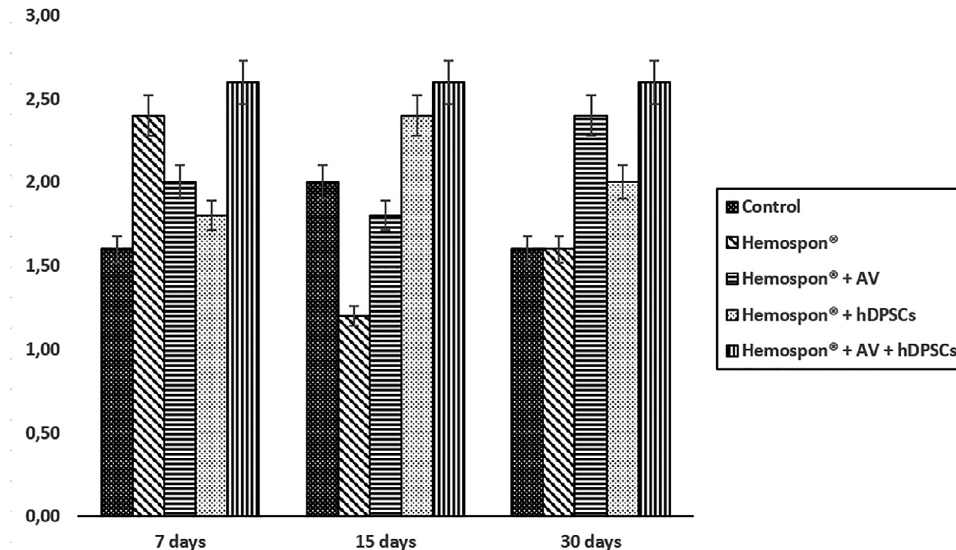
Figure 7- Average scores for the experimental groups’ osteopontin expression in each evaluated time